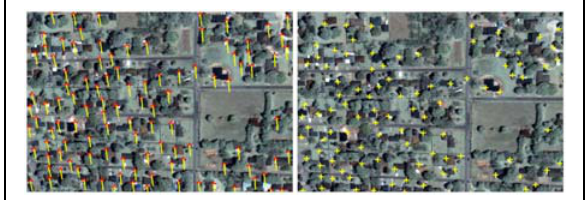
Figure 3. Corners in the first image are detected using Harris corner detector, and then Lucas-Kanade optical flow is applied to find corresponding feature points in the second image. Left image shows detected corners and optical flow vectors against the detected corners on the right image.